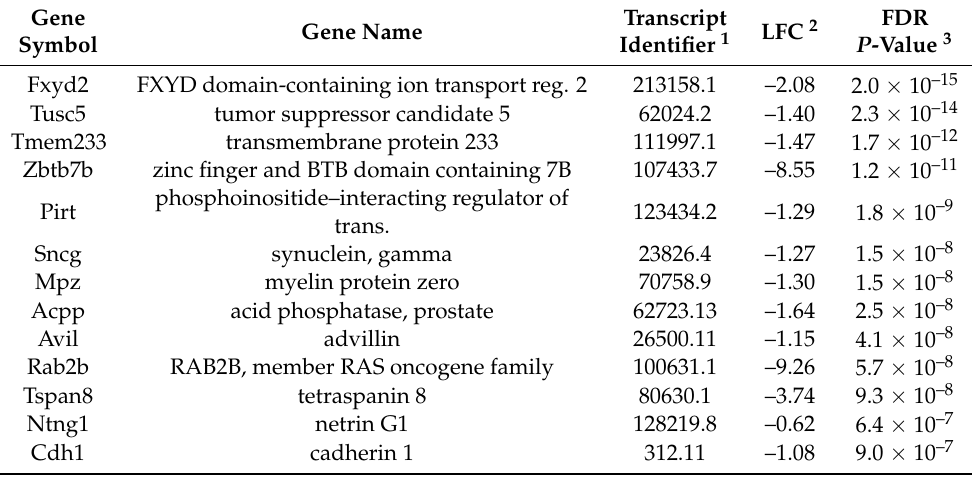
Table 1. Absolute differential expression of transcript isoforms (|fold change| > 2, FDR